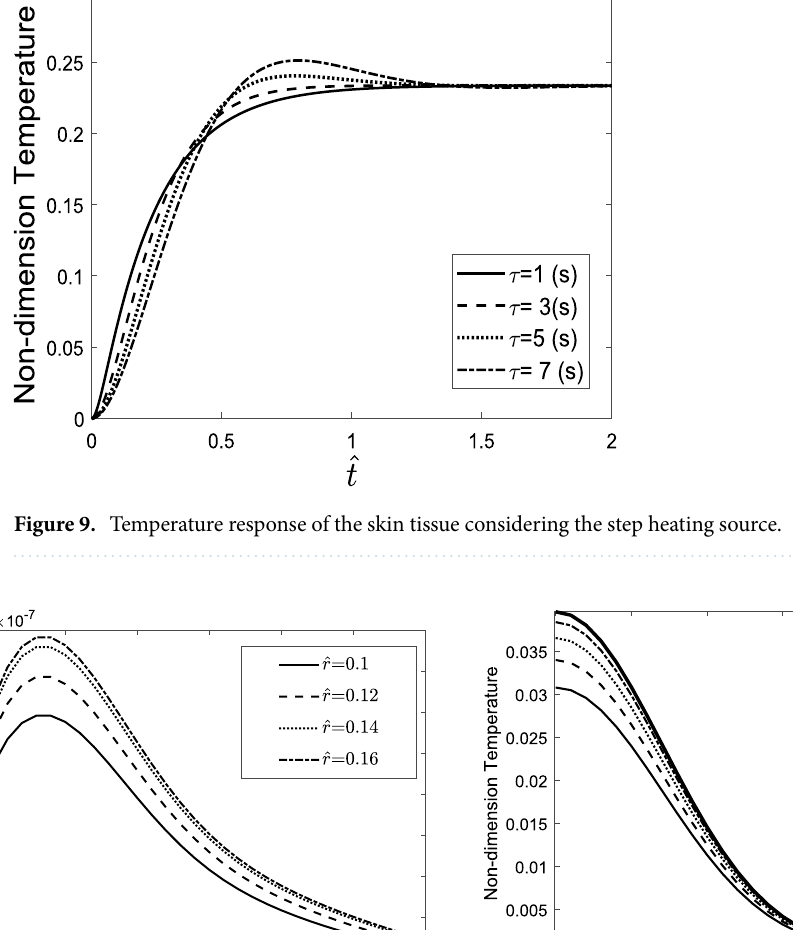
Figure 10. ( a ) Nondimensional displacement of tissue through the z-direction versus and ( b ) temperature distribution through the z-direction for different values of